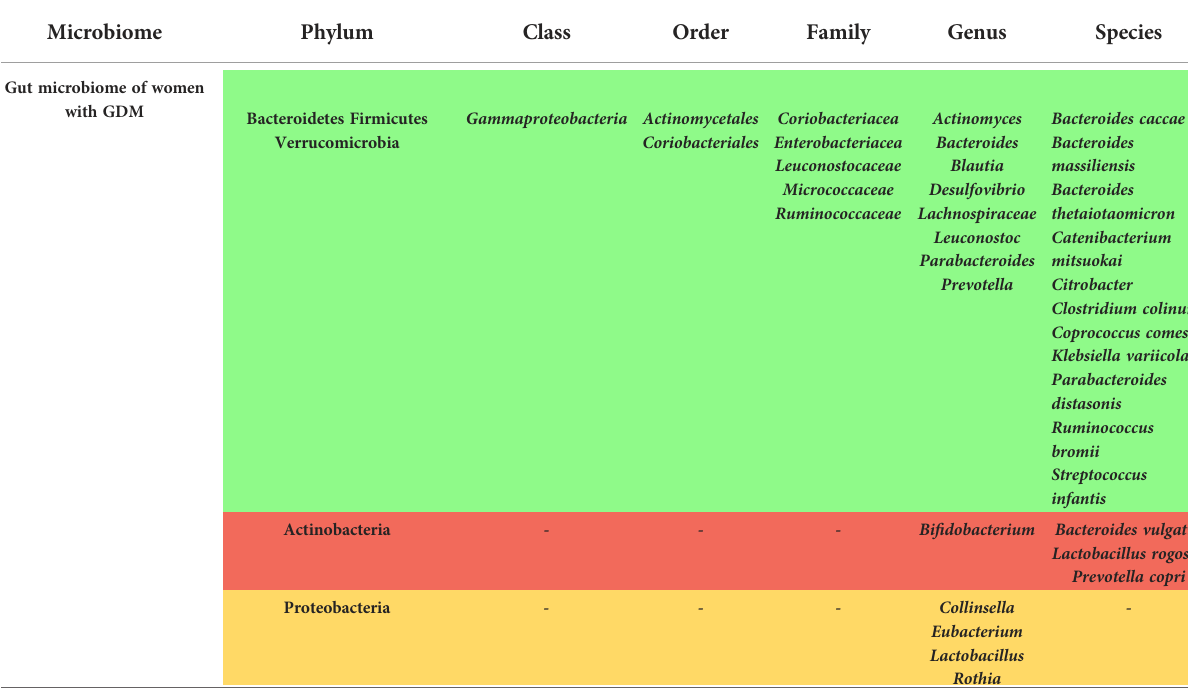
TABLE 1 Summary of the gut microbiome alterations in offspring to patients with GDM ( = Increased, = Decreased, =